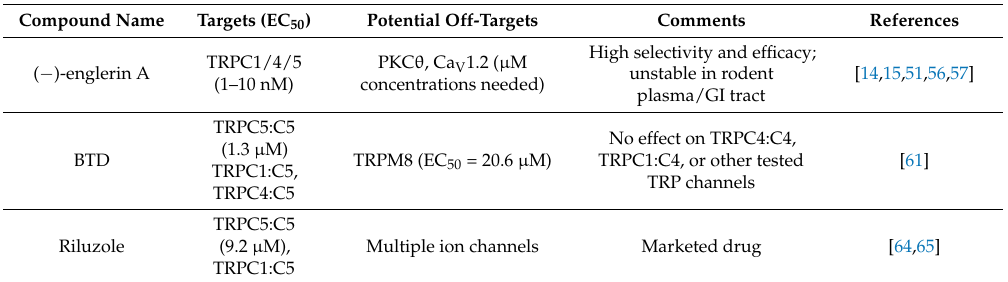
Table 1. Overview of selected TRPC1/4/5